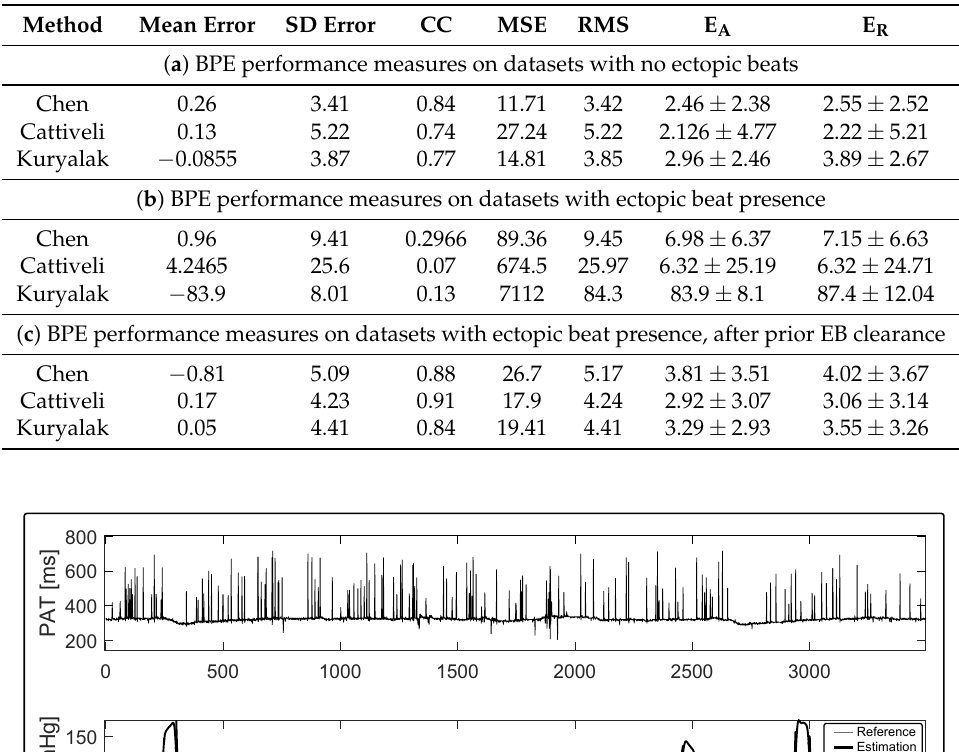
Table 8. Blood pressure estimation (BPE) performance evaluation. ( a ) BPE error measurements on clean datasets to verify the respective BPE reimplementations; ( b ) BPE error measurements on datasets containing ectopic beats; ( c ) BPE error measurements on the same datasets used in ( b ) where the ectopic beat cancellation using the multimodal method proposed in this work has been applied prior to the BPE process.